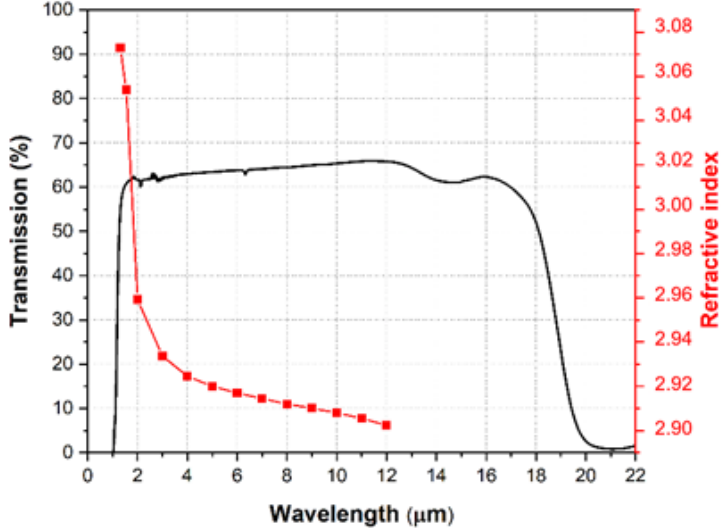
Figure 2. Transmission and refractive indices of Te 20 As 30 Se 50 chalcogenide glass in the mid-infrared spectral region